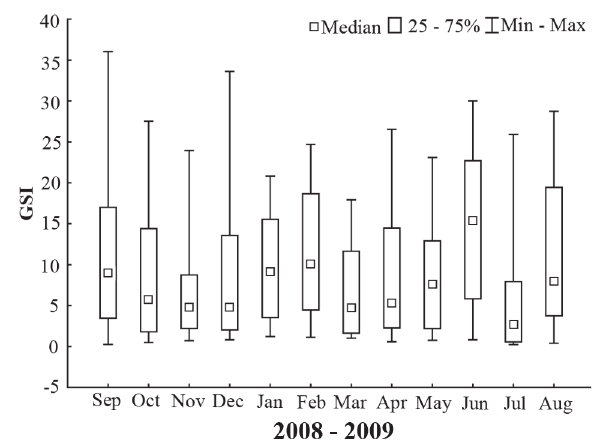
Fig. 8. Monthly variation in the gonadosomatic index (GSI) in Anableps anableps females collected at the mouth of the Maracanã River, Pará State.